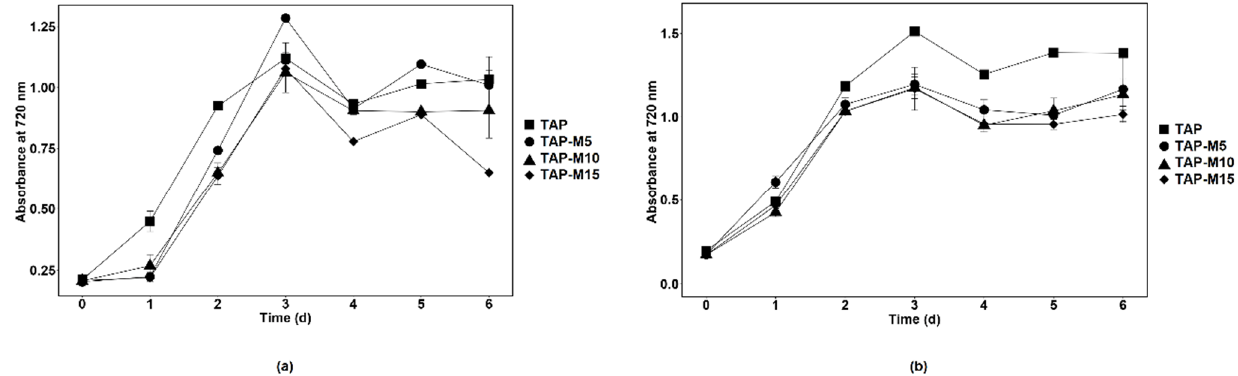
Figure 1. Growth of Chlamydomonas sp. MACC-216 ( a ) and Chlorella sp. MACC-360 ( b ) in TAP, TAP-M5, TAP-M10 and TAP-M15. Error bars represent standard deviations.